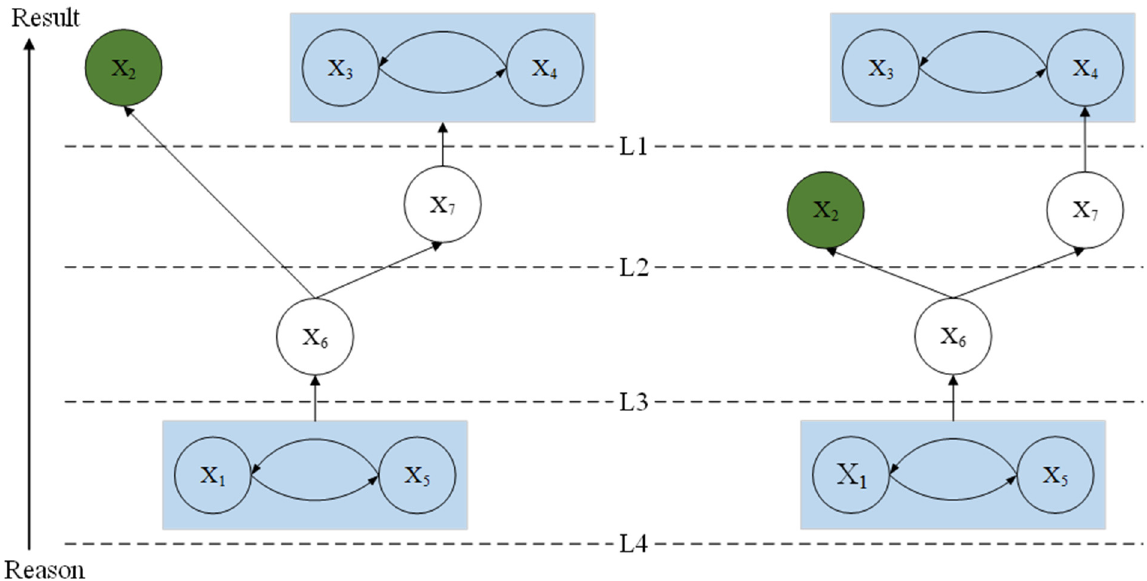
Figure 2. Topological hierarchy diagrams. UP-type hierarchical topology diagram ( left ) and DOWN-type hierarchical topology diagram ( right ) are drawn, reflecting the multi-level system of farmers’ accepting CPD. X 1 –X 7 are, respectively: agri-income, risk of pest, risk of health, risk of environment, cooperative, information acquisition, and government publicity.